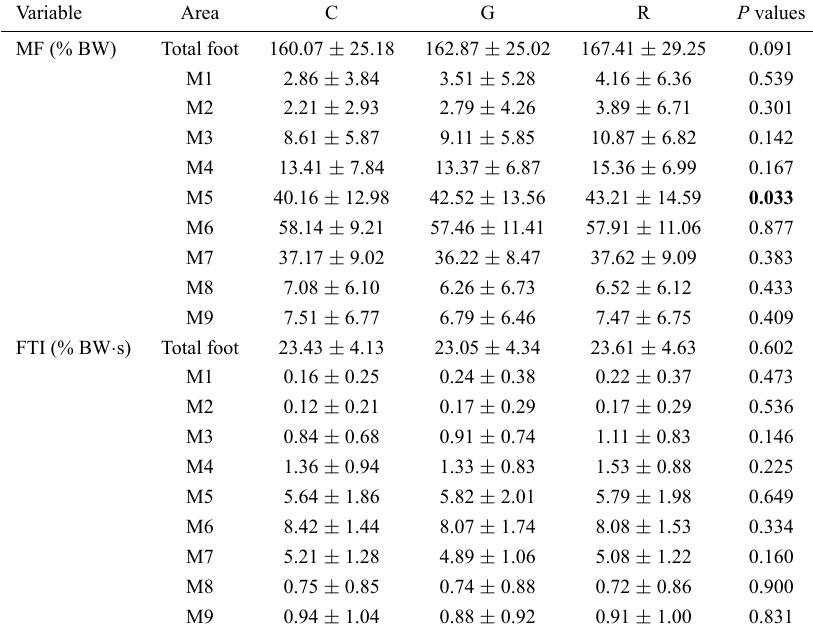
Table 2. Comparison of MF and FTI for running on different